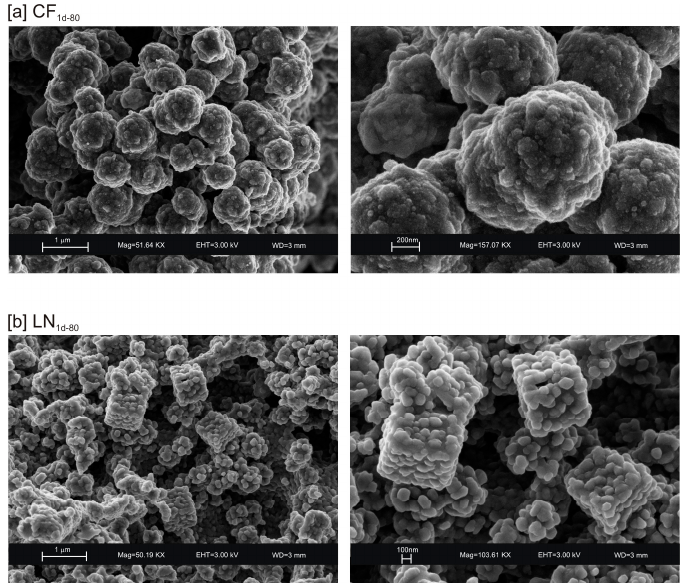
Figure 3. SEM images of: ( a ) CF and ( b ) LN samples after drying 80 °C.